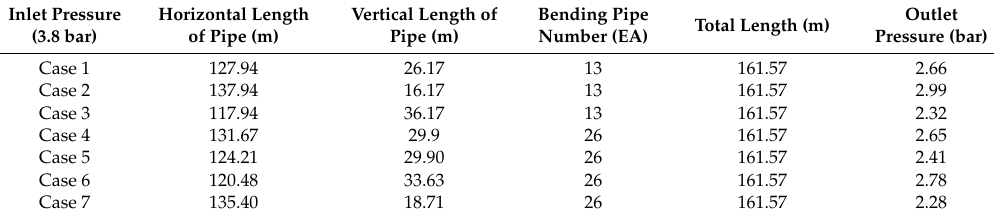
Table 6. Case simulation parameters with test scenario.